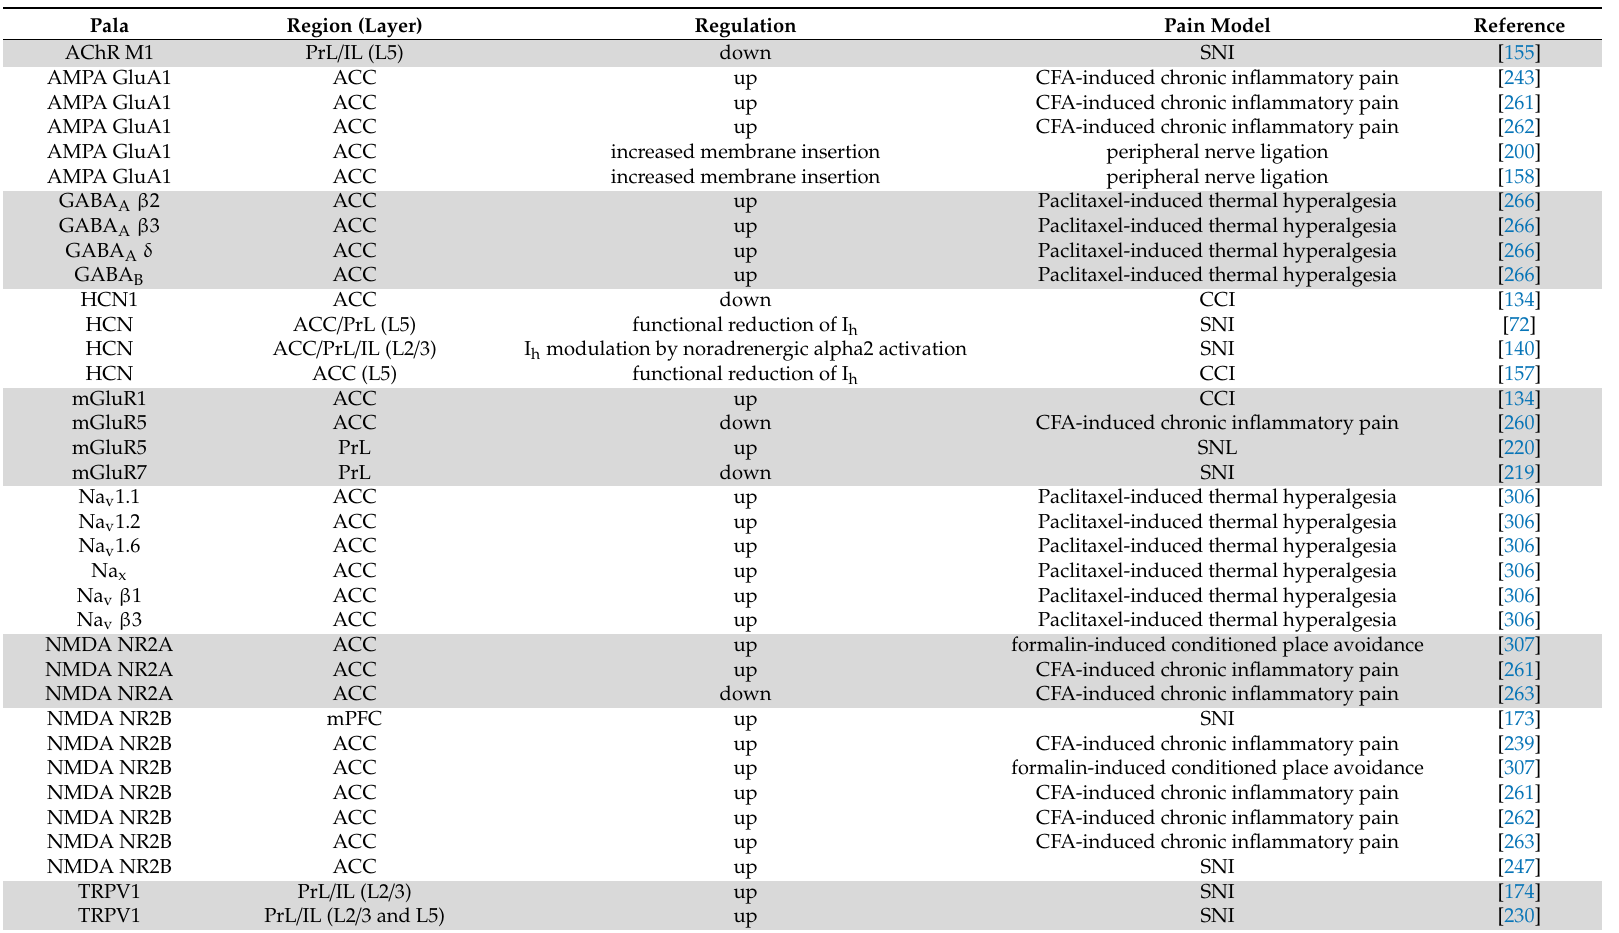
Table 1. Regulation of neurotransmitter receptors and ion channels in the di ff erent subregions and layers of the mPFC.